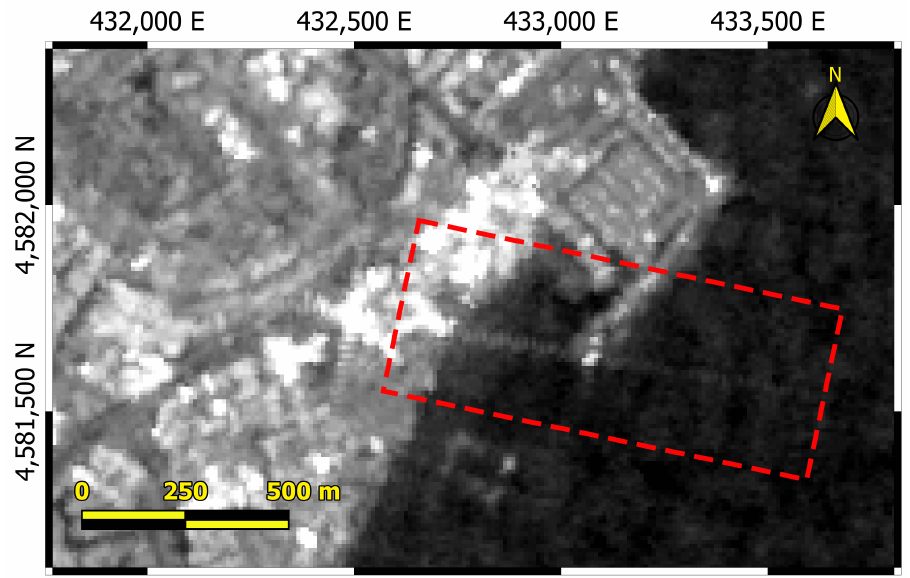
Figure 5. Zoom of Somorrostro Sentinel-1 SAR image. The red rectangle points at the scatterers that create sidelobes, which introduce noise for shoreline